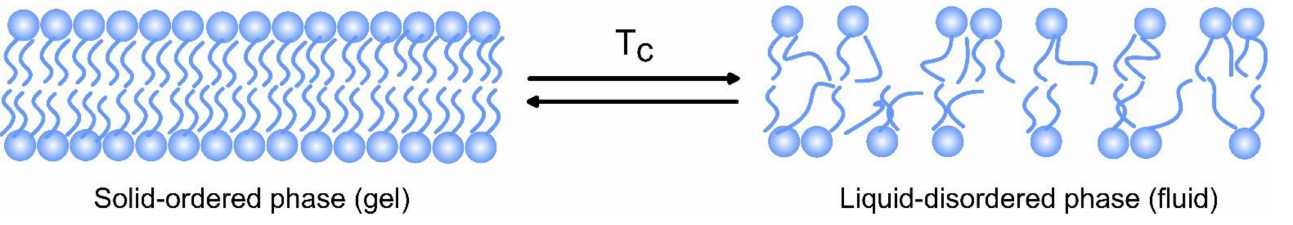
Figure 13. A schematic presentation of “gel” to “liquid” transition of thermoresponsive liposome formulations occurring during mild hyperthermia and controlling drug